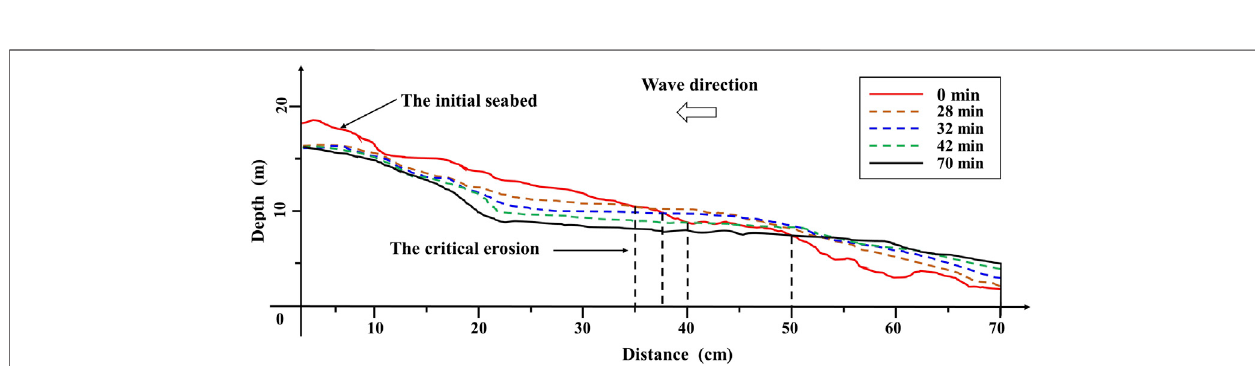
FIGURE 8 | Water content (bluish violet) and median particle size (orange) of sediments in the four areas as compared to their original values. Zone Ⅰ and Ⅱ present the particle coarsening, and zone Ⅲ and Ⅳ present the particle re fi nement.